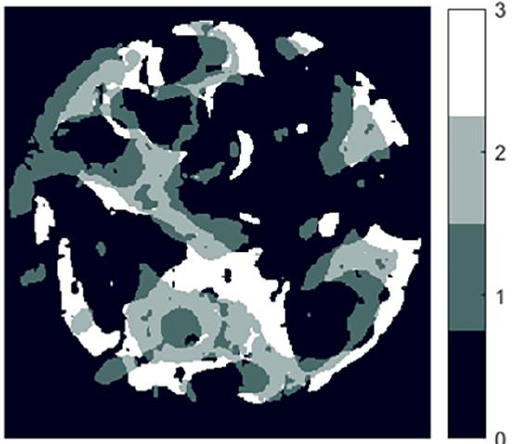
Figure 3. Layers of the superimposed 3D images indices and correlated colors of the different regions; 0 background, 1 sample 3D image, 2 overlay area, 3 initial.